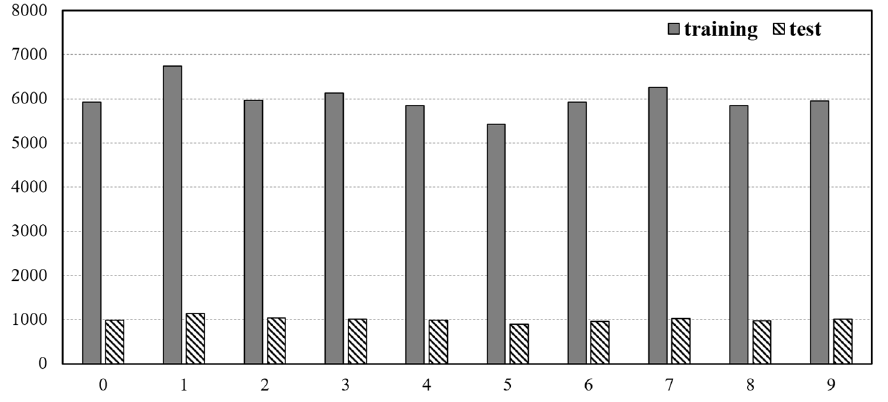
Figure 3. MNIST dataset distribution. Table 6. Simulation result of Condensed k-NN, k-NN in MNIST